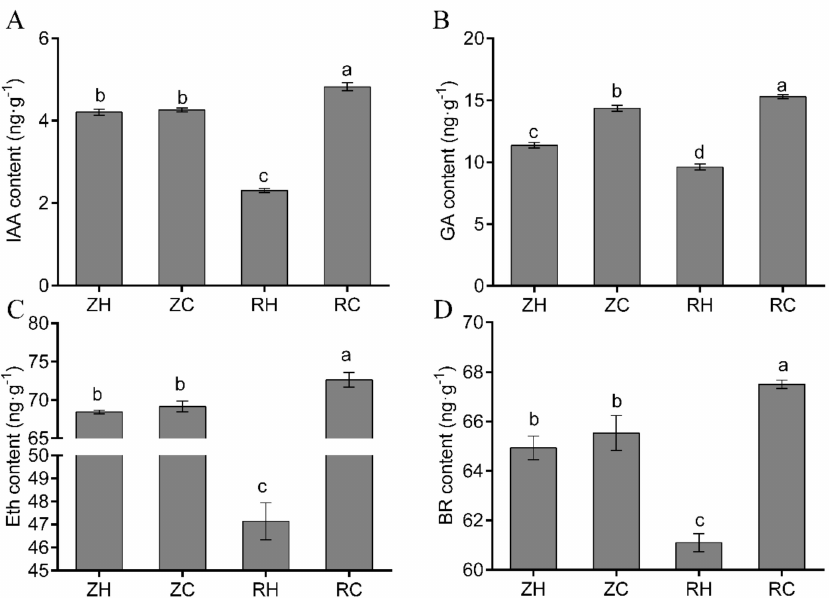
Figure 8. E ff ects of exogenous Ca 2 + and weak light on endogenous hormone in potatoes. We measured the levels of ( A ) IAA, ( B ) GA, ( C ) Bra, and ( D ) Eth in di ff erent treatments. Values represent the mean ± S.E. ( n = 3). Letters indicate significant di ff erences at p < 0.05 according to Duncan’s multiple range